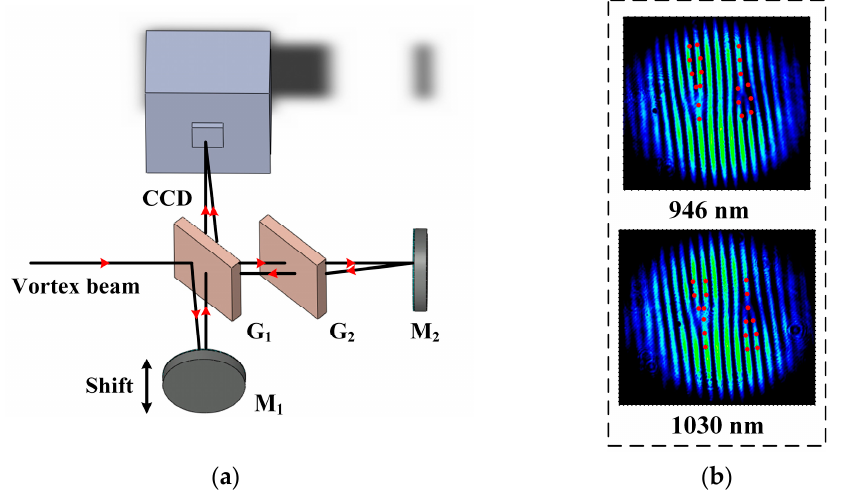
Figure 11. ( a ) The optical path diagram of the wavefront phase detection device, and ( b ) the meas- urement results.